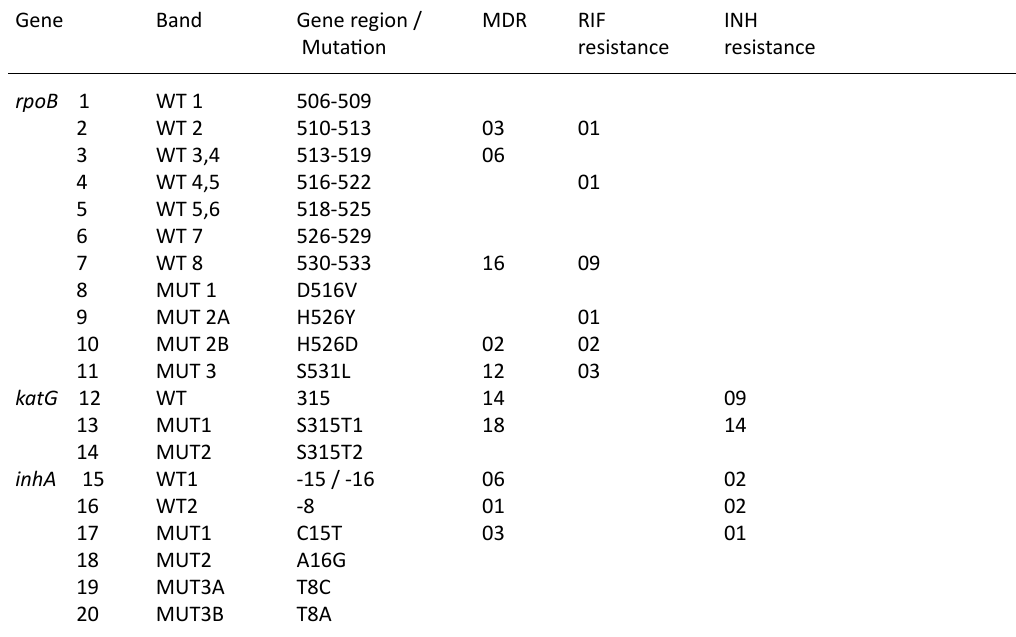
Table 6. Frequency of gene mutation associated with resistance to rifampicin ( rpoB ) and isoniazid ( katG or inhA )